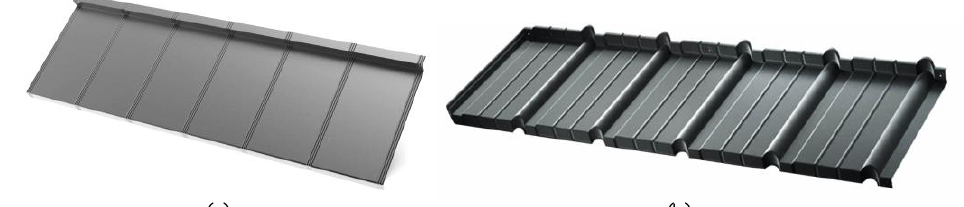
Fig. 3. (a) Tysenia and (b) Murano roof